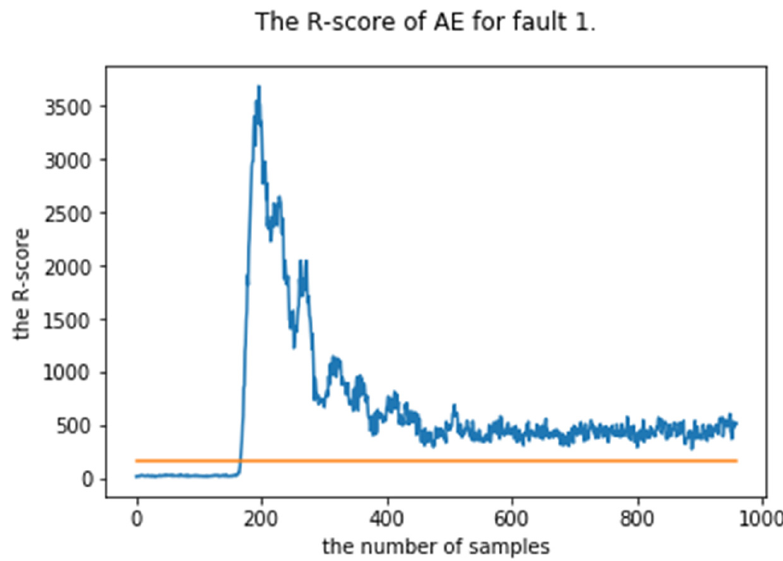
Figure 9. The R-score of the AE for fault 1.